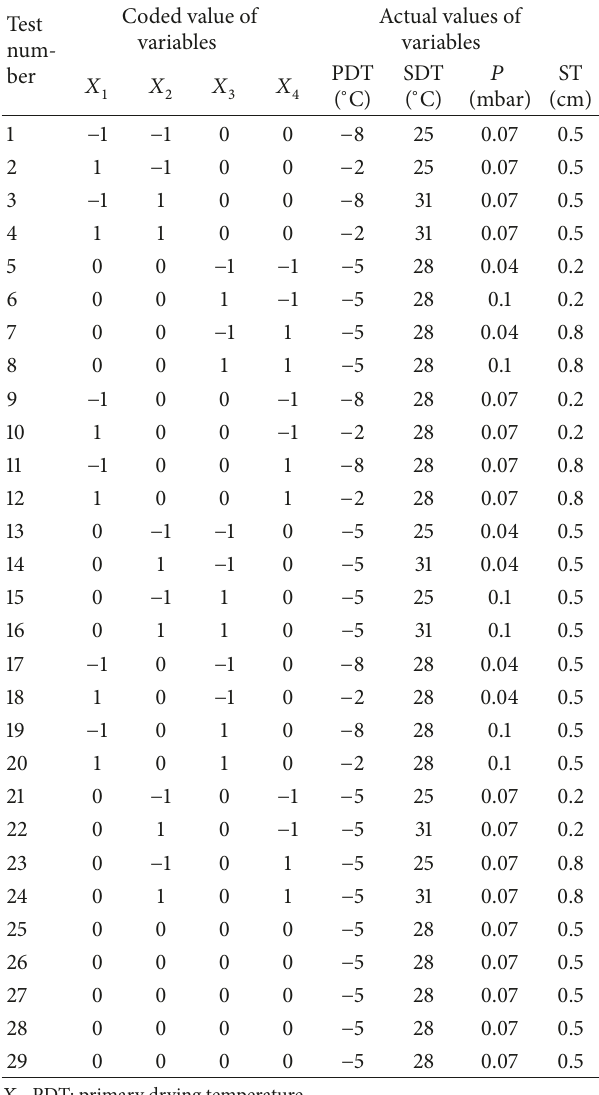
Table 1: Experimental design (Box-Behnken) followed for freeze- drying of